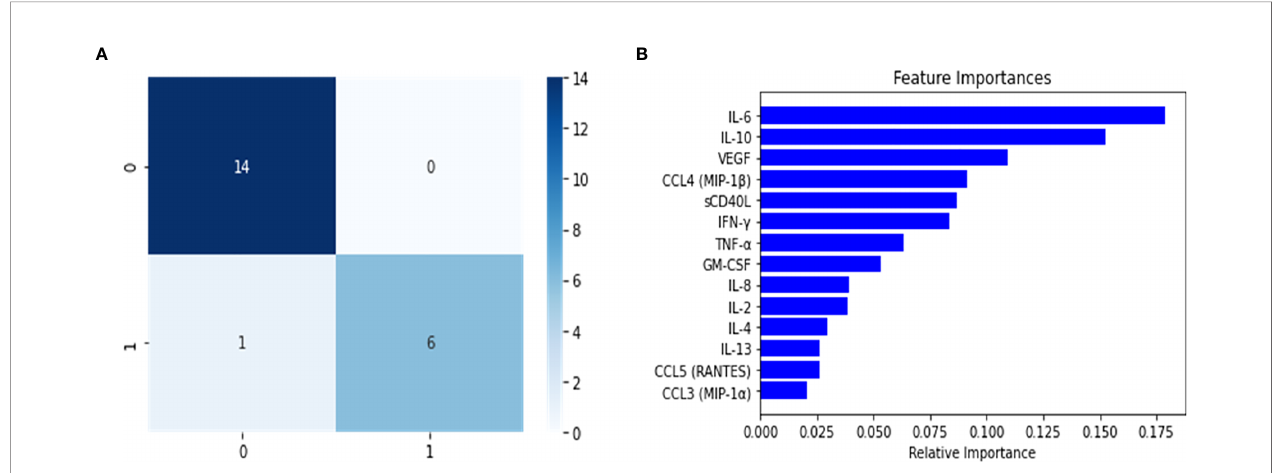
FIGURE 3 | Confusion Matrix (A) and feature importance (B) for the PASC binary random forest classi fi er to enable the feature engineering of a score for the identi fi cation of PASC patients. The positive class (1) are PASCs while the negative (0) class are the non-PASCs (healthy control, Mild-Moderate-Severe).